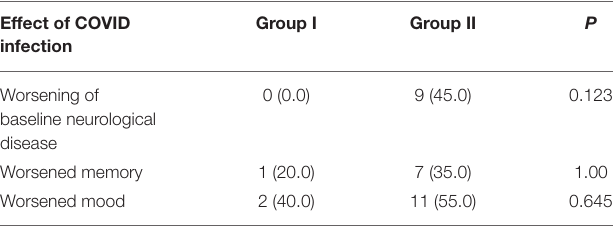
TABLE 4 | Sequence of COVID infection on different neurologic symptoms. Effect of COVID infection